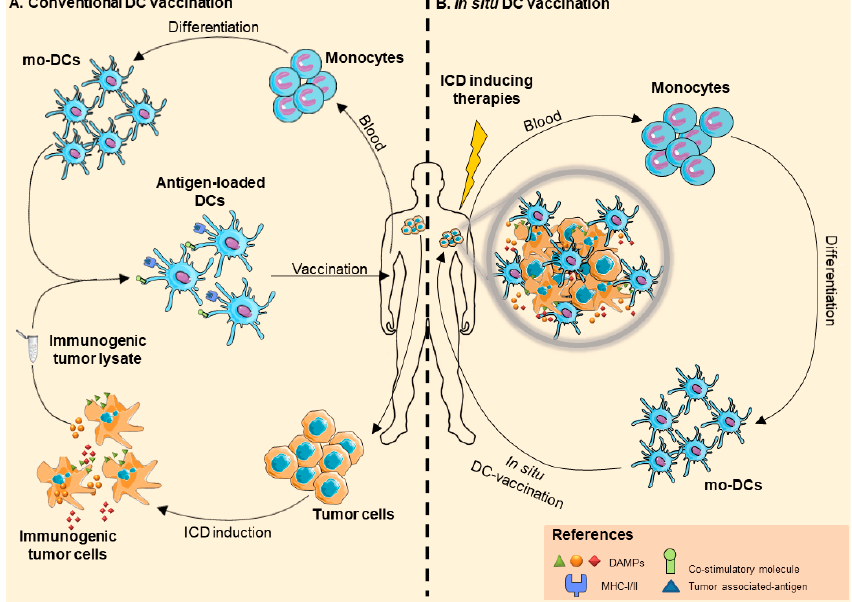
Figure 2. Different strategies that combine ICD induction and DC-based vaccination . (A) Exploiting conventional DC vaccination in an ICD context consists of the development of ex vivo tumor cell lysate-loaded autologous DCs that are administered systemically in order to trigger tumor-specific immune responses. In this case, ICD is induced ex vivo in patient cancer cells from which tumor lysates are prepared. (B) In situ DC vaccination is based on the local administration of ex vivo generated autologuos mo-DCs into the tumor site. In this context, the patient is pre-treated with an ICD-inducing therapy in order to achieve in vivo immunogenic apoptosis and consequent expression of tumor-associated antigens (TAAs) and DAMPs. Intratumor injection of mo-DCs allows in situ TAA presentation and tumor-specific cytotoxic T lymphocyte (CTL) activation, resulting in an expanded antigenic repertoire of T lymphocyte responses. Some images in the figure were created using Servier Medical Art images (http://smart.servier.com).